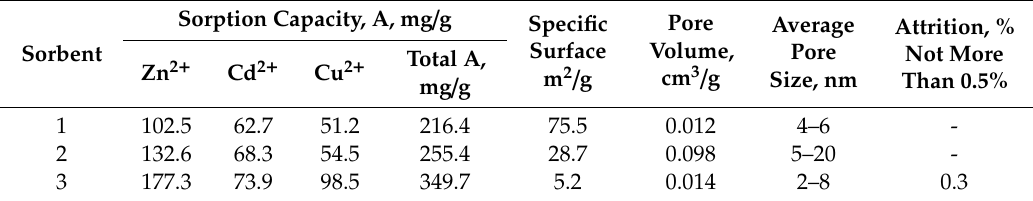
Table 3. The maximum sorption capacity for sorbents made of residual biomass of C. sorokiniana microalgae and chitosan.